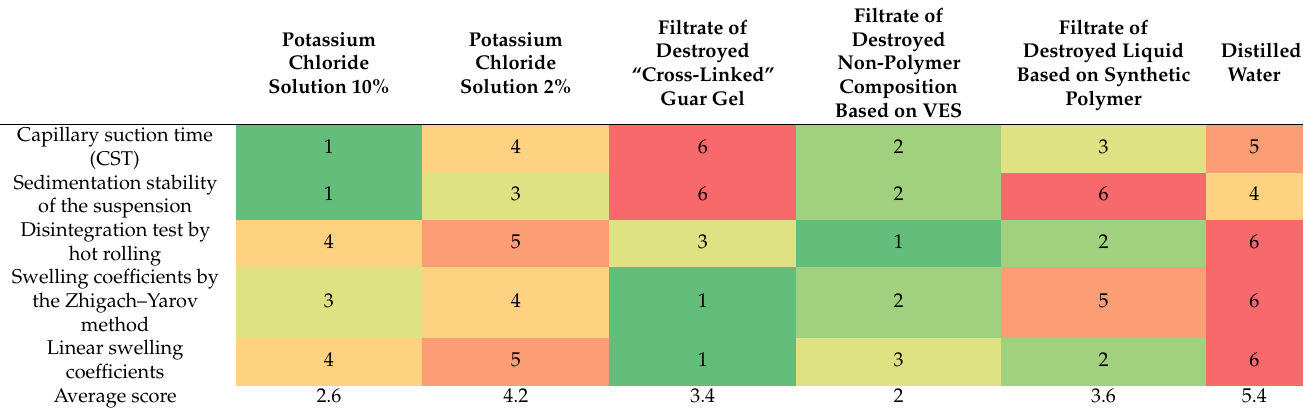
Table 3. Table summarizing the results of assessing the swelling of clays using various